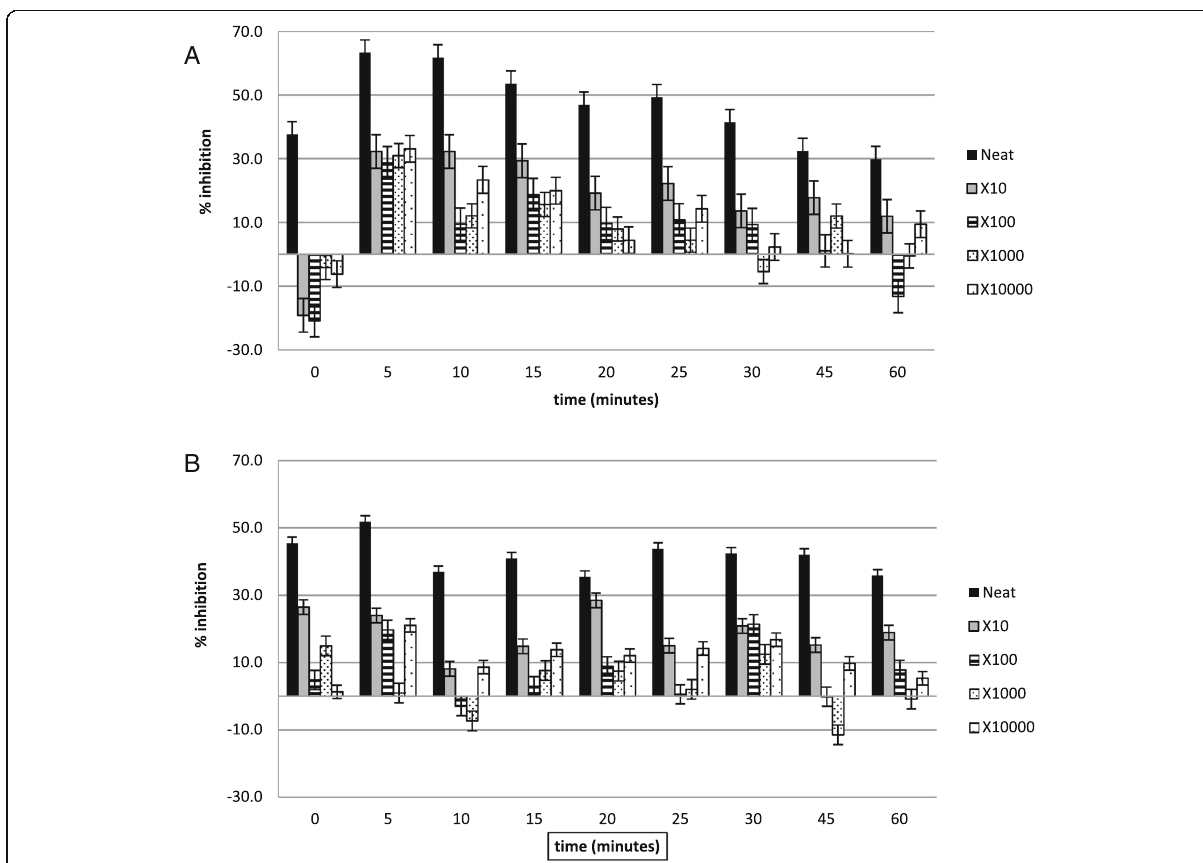
Fig. 3 The % inhibition of healthy platelets after incubation with the HM2 and diluted standards, and activation with ( a ) fMLP and ( b )